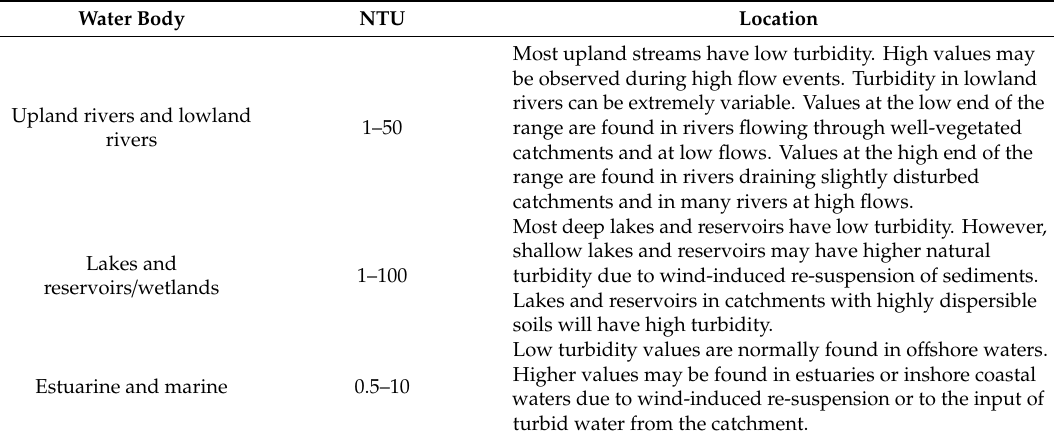
Table 1. Typical turbidity values for a range of di ff erent water